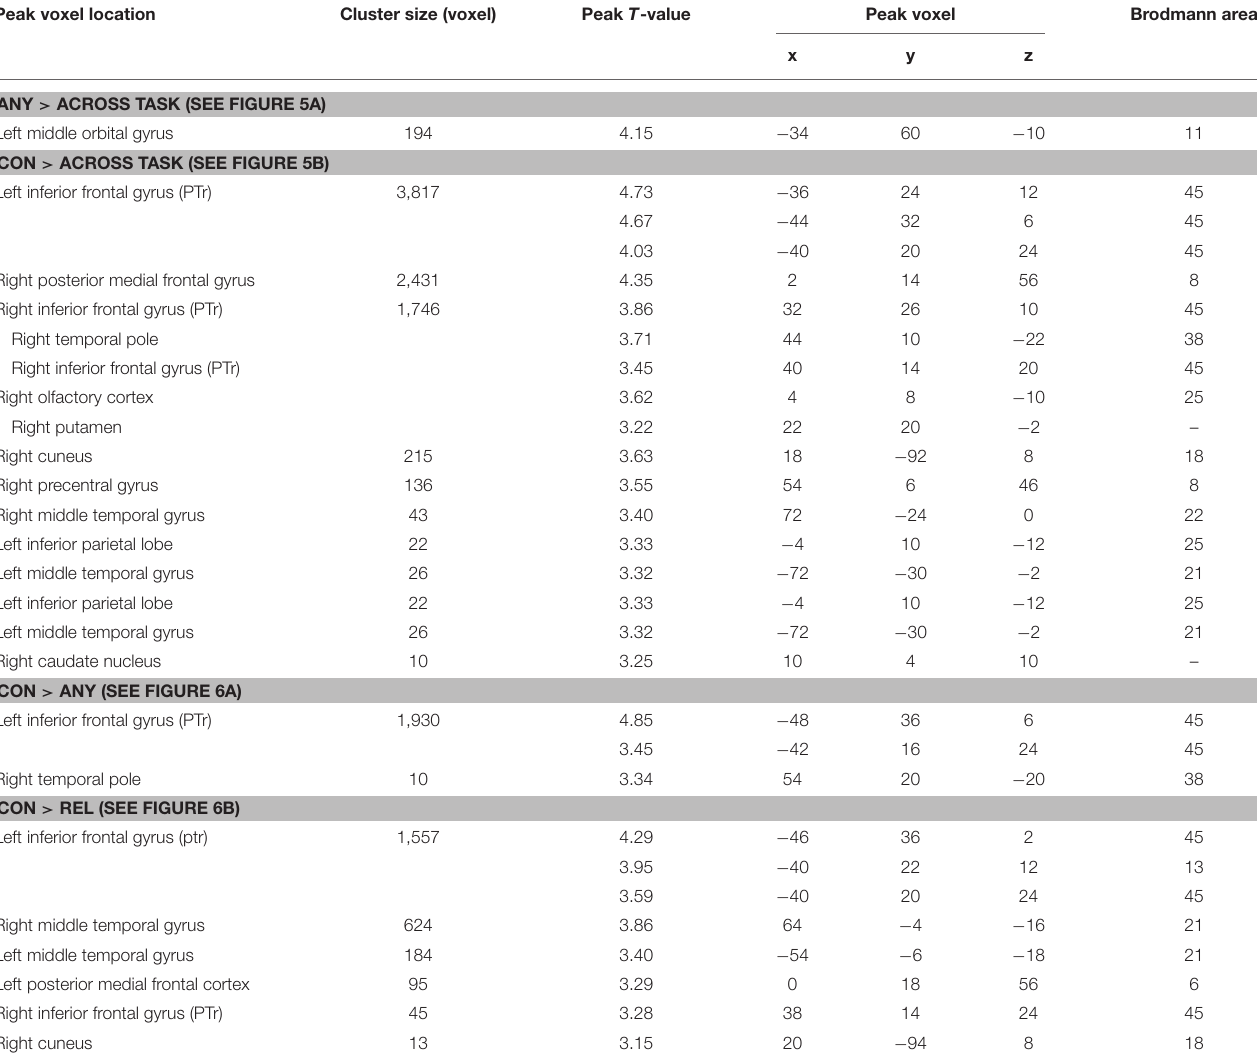
TABLE 3 | Cluster table for exploratory ISC maps. Peak voxel